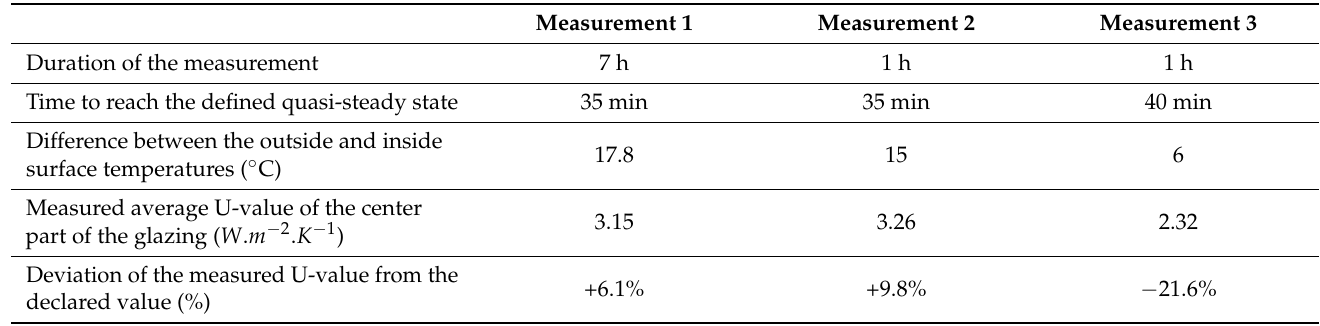
Table 5. Summary of the results of the three measurements of an existing double-pane window using the rapid U-value meter. Conducted by Feng et al.